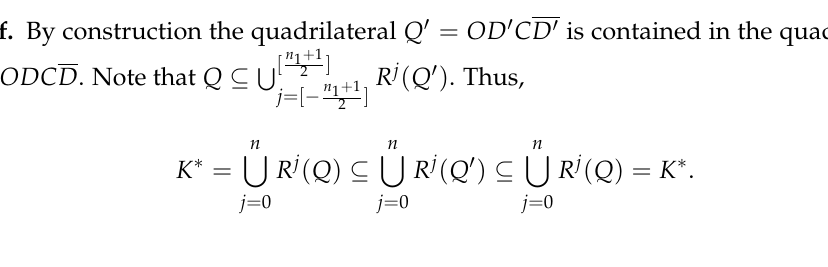
Figure 5. The dart in the figure is the quadrilateral Q (cid:48) = OD (cid:48) CD (cid:48) , which is the union of the triangles T = ∆ OD (cid:48) C and the triangle T (cid:48)